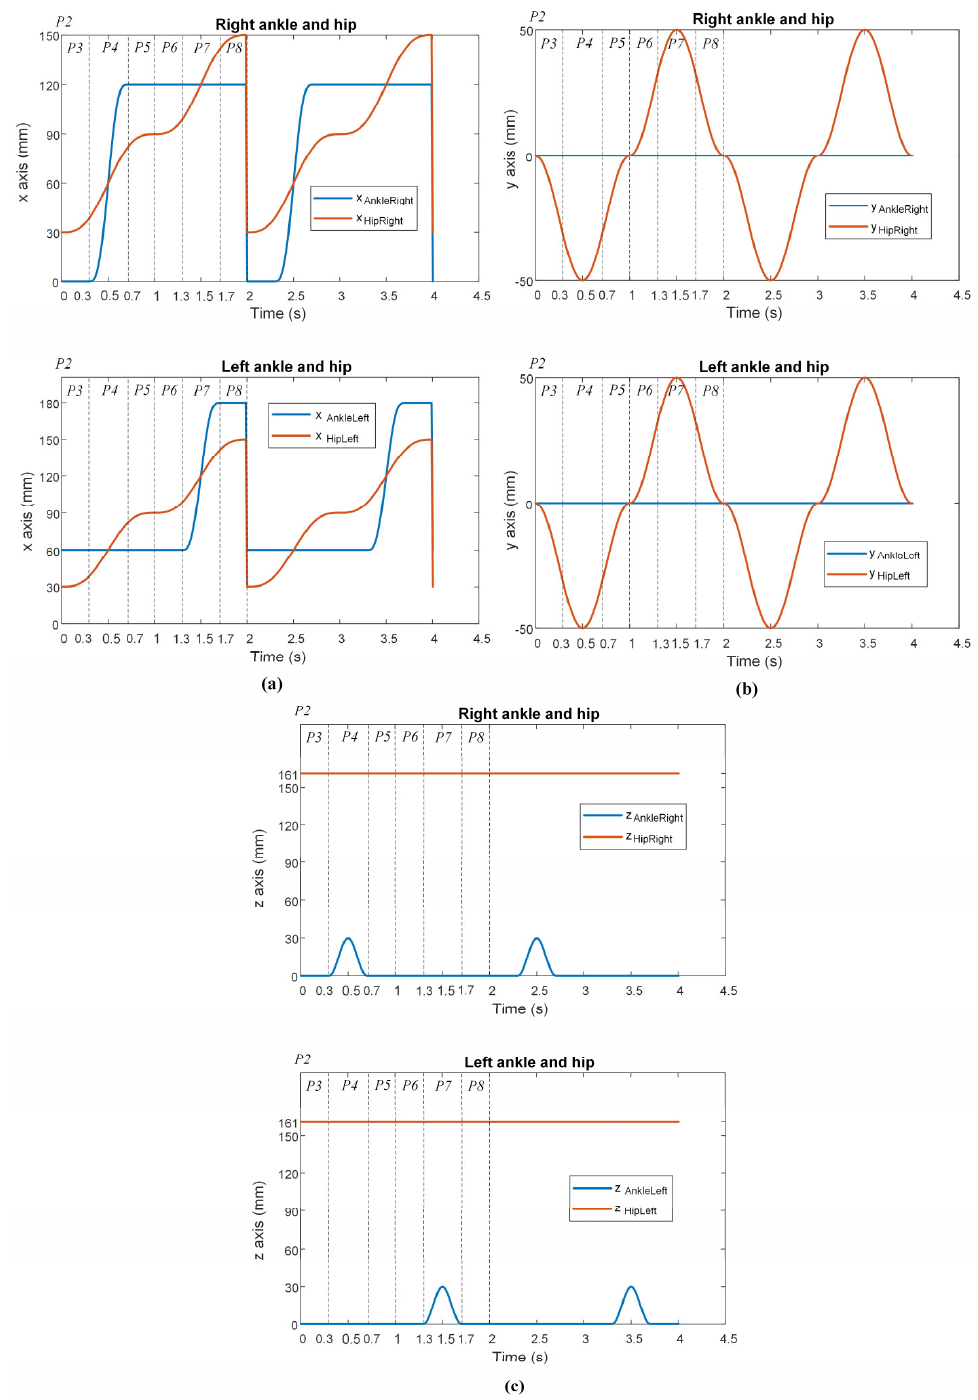
Figure 19. Trajectories of the ankle and hip: ( a ) x-axis, ( b ) y-axis, ( c ) z-axis. The walking algorithm inside the Robotis-OP2 uses a method to construct a gait model based on CPG-based paired oscillators that perform sinusoidal trajectories [60]. Many parameters are available in the algorithm to adjust the gait. However, it has been decided that only a subset of these parameters can be set to facilitate its use by the user [55]. Other parameters are set to default values that are known to work well. The robot’s gait can be adjusted if the user wishes by changing the default values stored in the “config.ini” configuration file shown in Figure 20